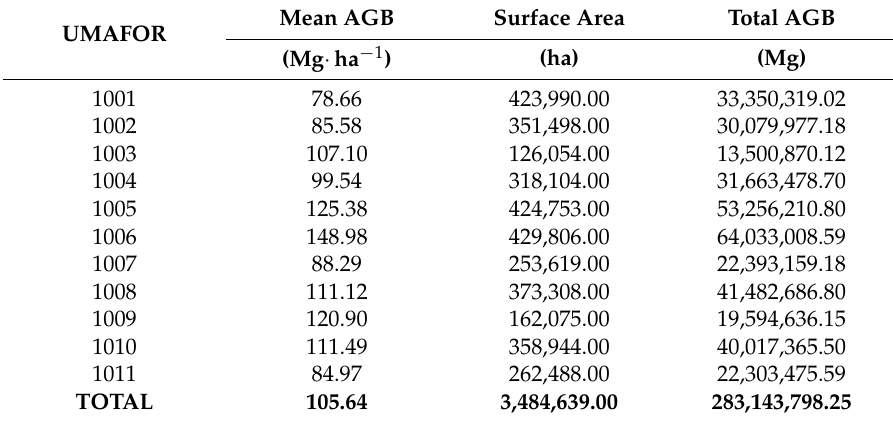
Table 3. Estimation of AGB for the regional forest management units in the SMO, state of Durango, Mexico. Mean AGB Surface